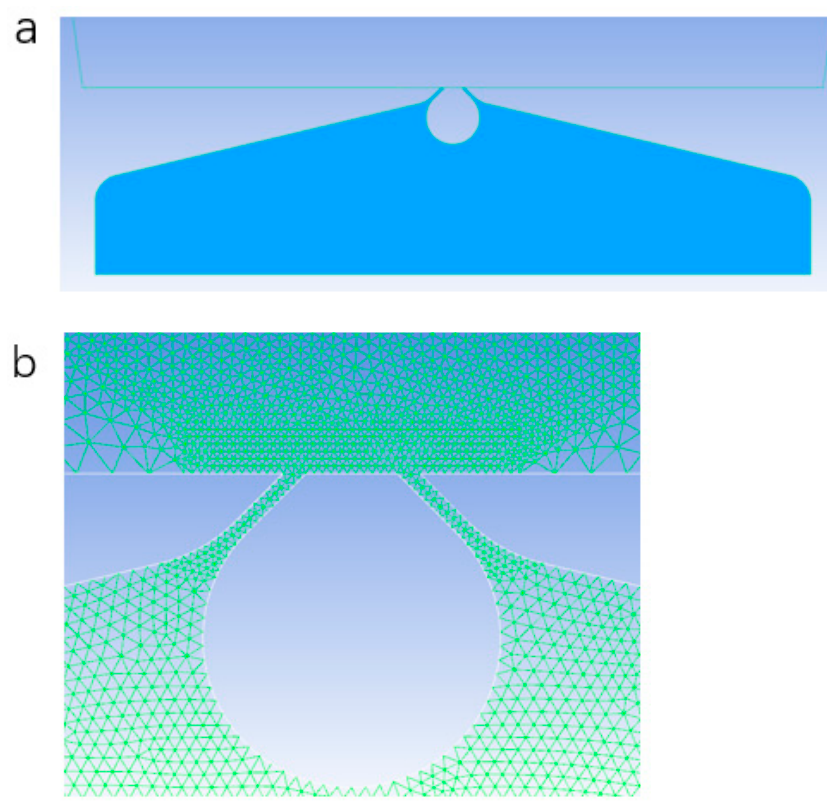
Figure 6. ( a ) Geometric model; and ( b ) mesh.